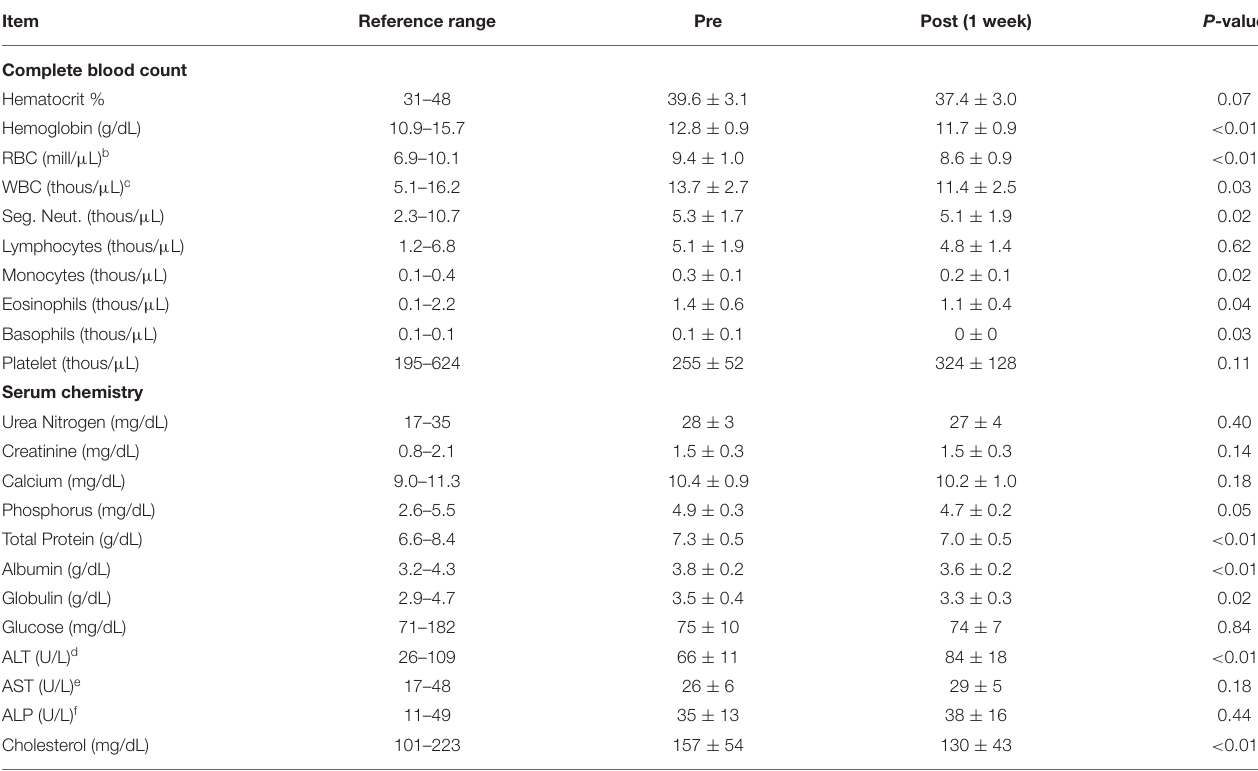
TABLE 2 | Complete blood counts and selected serum chemistry profile in cats before (pre) and 1 week (post) after oral administration of a CBD/CBDA rich hemp paste a